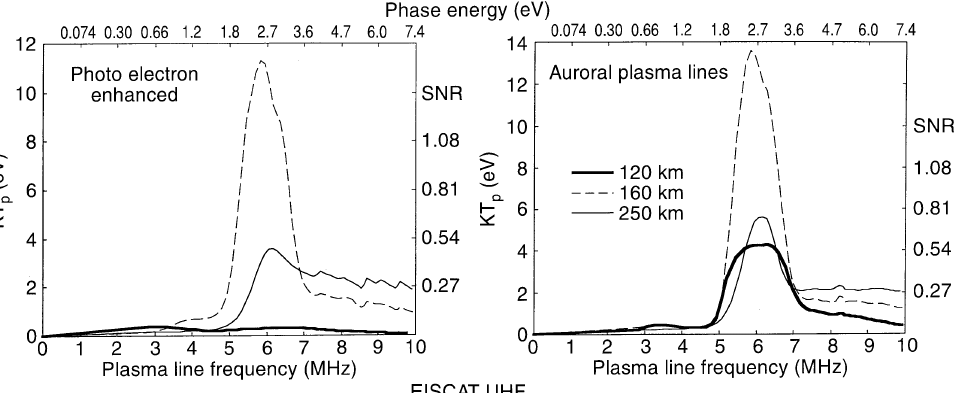
text for details). The lower x - axis gives the plasma line frequency, while the upper gives the phase energy for the resonant electrons (for comparisons with Fig.